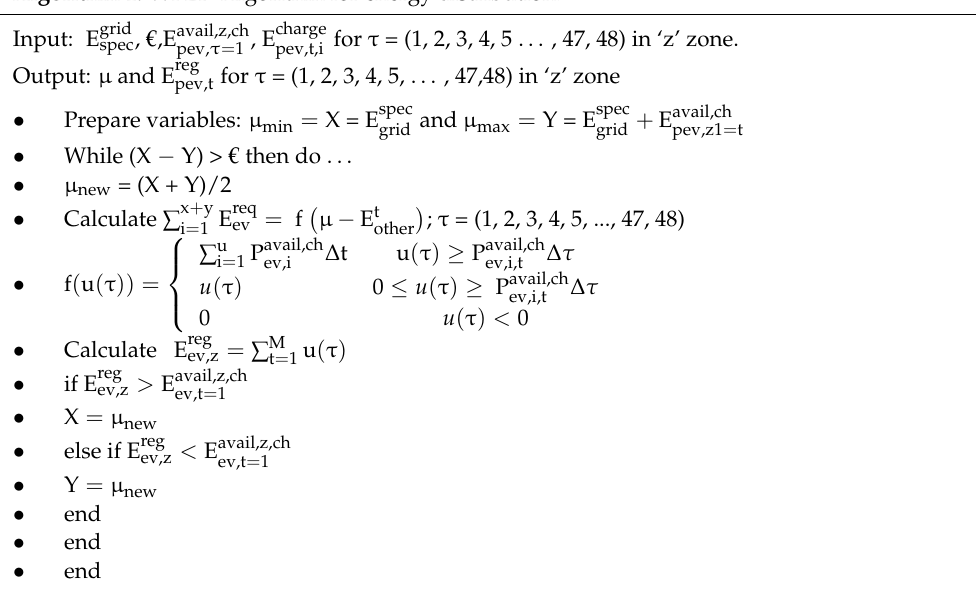
Algorithm 1. WFED Algorithm for energy